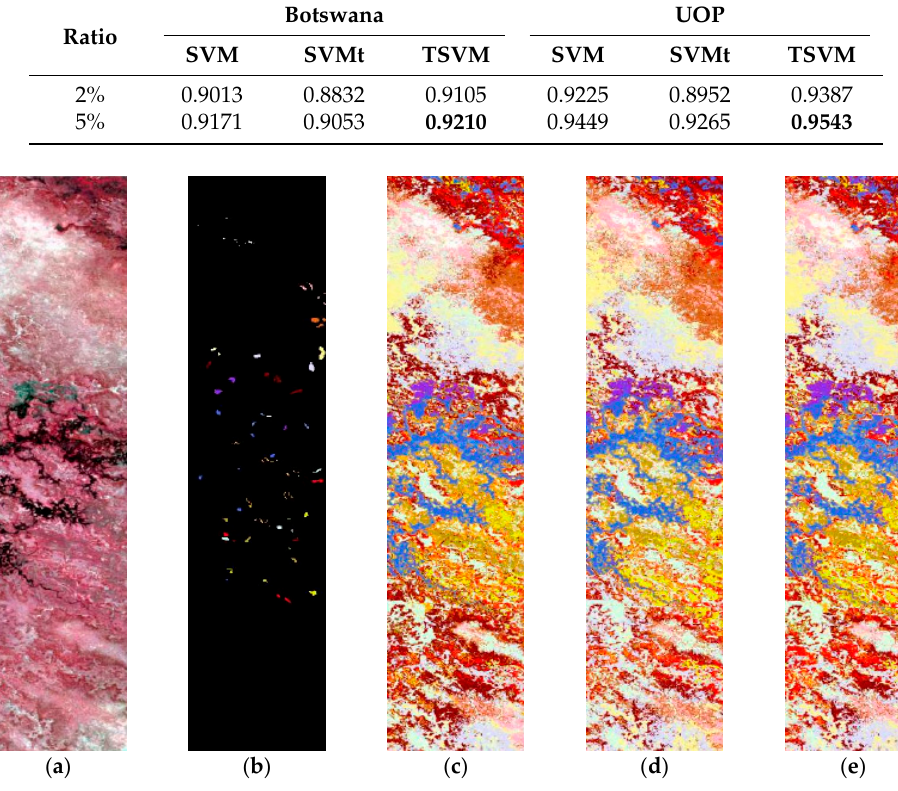
Figure 4. Classification maps achieved on the Botswana dataset. ( a ) RGB map; ( b ) Ground reference map; ( c ) SVM; ( d ) SVMt; ( e ) TSVM.